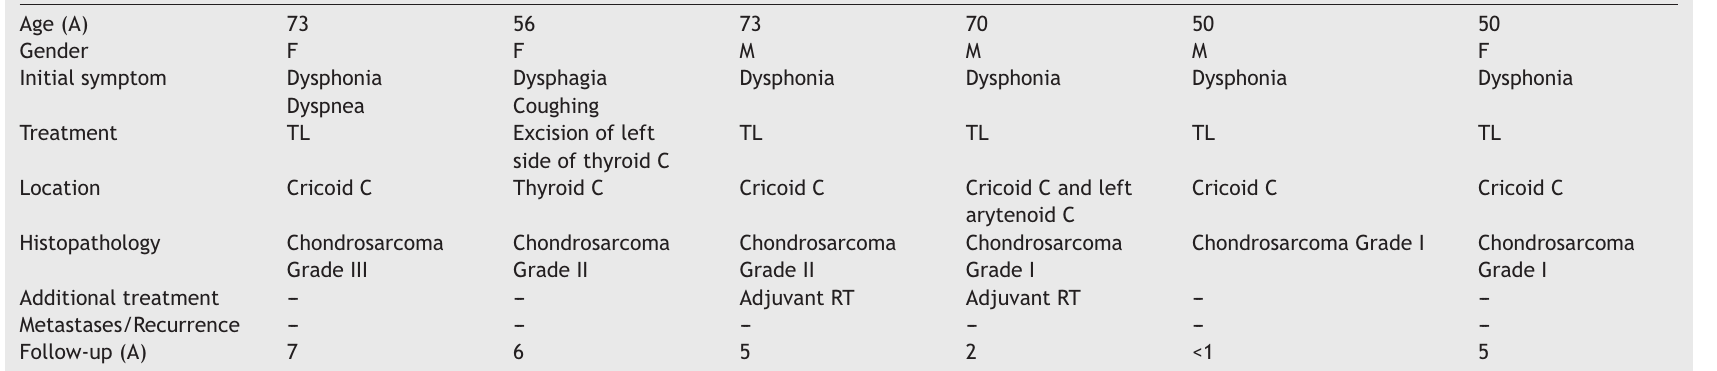
Summary of case series: patients with laryngeal chondrosarcoma (2002---2012). Age